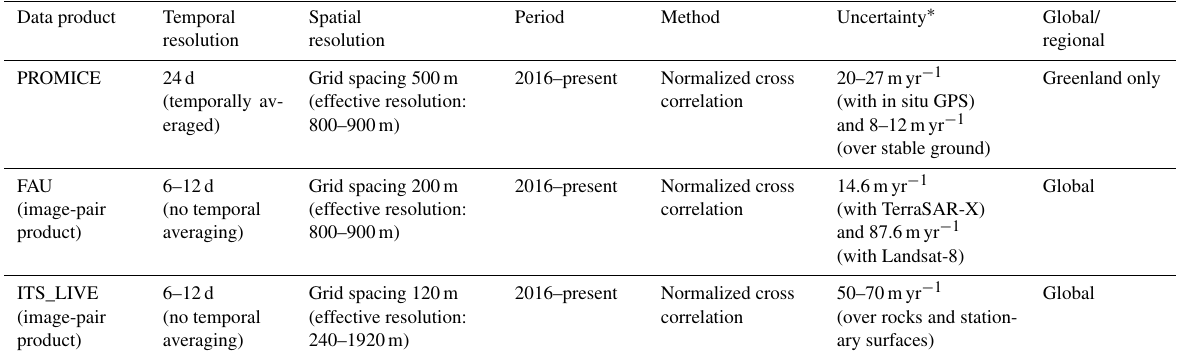
Table 1. Sentinel-1 based data product specifics of PROMICE, FAU and ITS_LIVE. Data